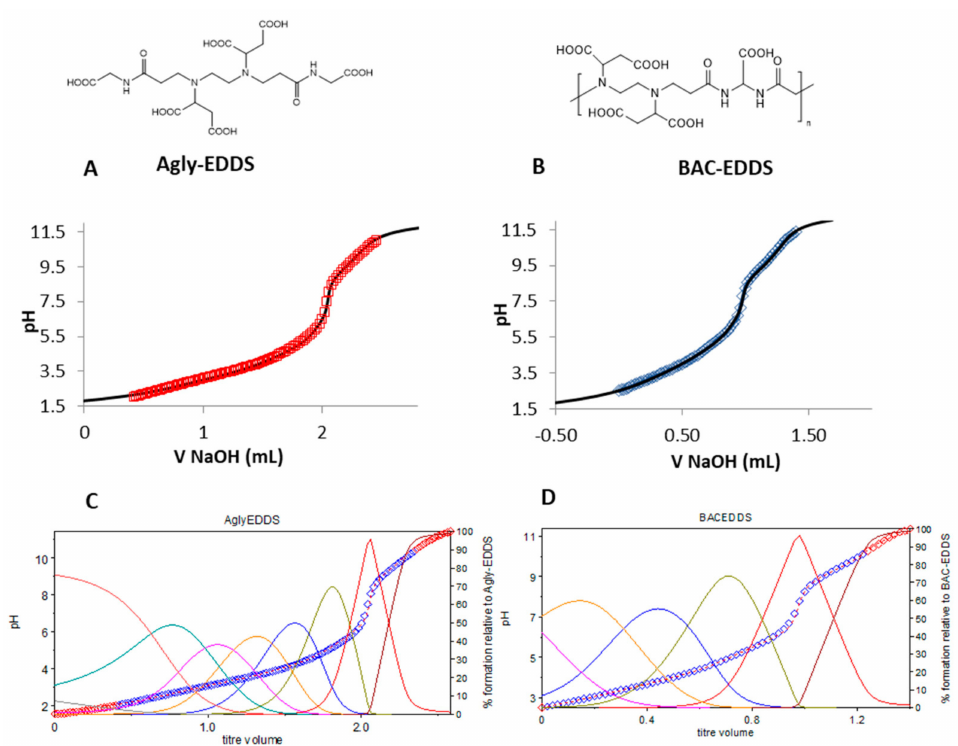
Figure 4. Superposition of the experimental data of the titration curves of ( A ) Agly-EDDS and ( B ) with NaOH and the simulation curves by the De Levie method. ( C , D ) Fitting of the same titration curves by Hyperquad software. The colored lines in panels ( C ) and ( D ) represent the speciation of the ligands expressed as % of the different protonated